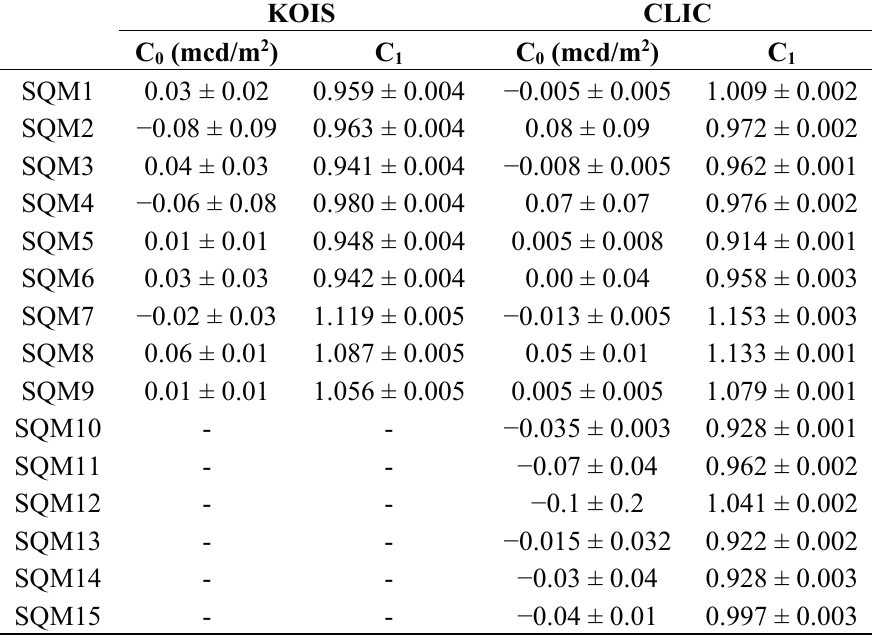
Table 4. Inter-calibration coefficients for KOIS and CLIC, after